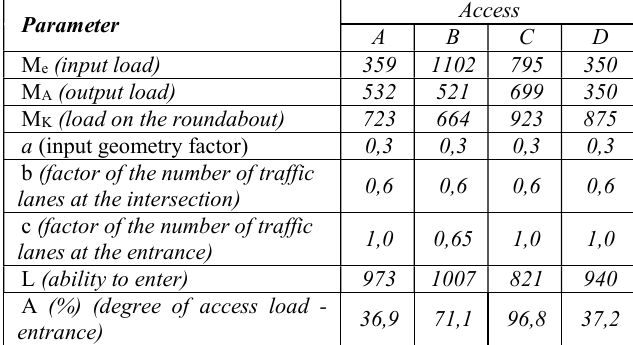
Table 6. Parameters of the intersection in Ilidža in the period 14:00 to 15:00 on November 9,